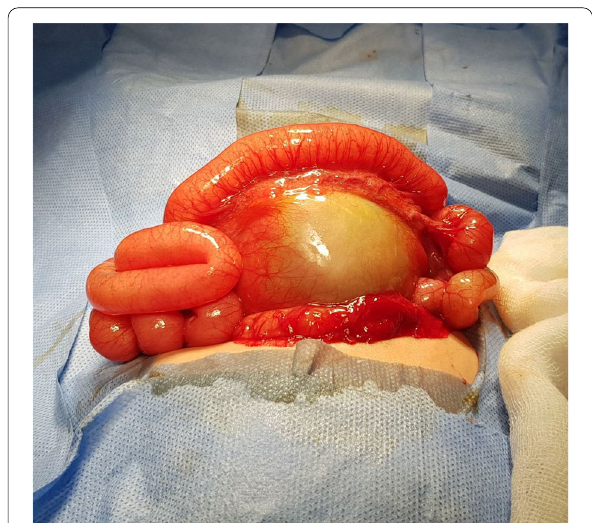
Fig. 4 The skull of the fetus bulging through the small intestinal mesentery of the delivered